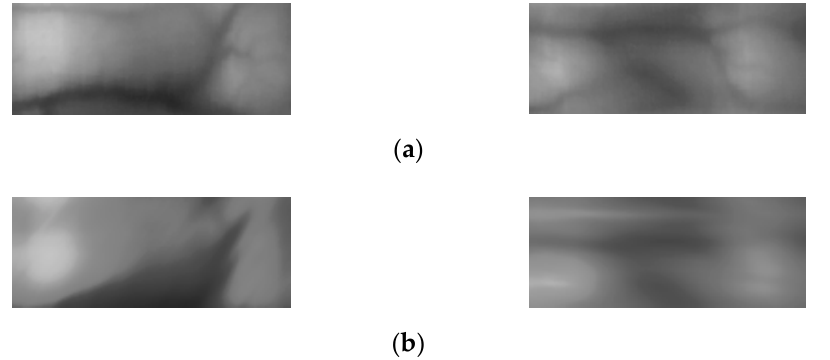
Figure 9. Examples of original images and motion blurred images of SDU-DB. ( a ) Original images; ( b ) motion blurred images.